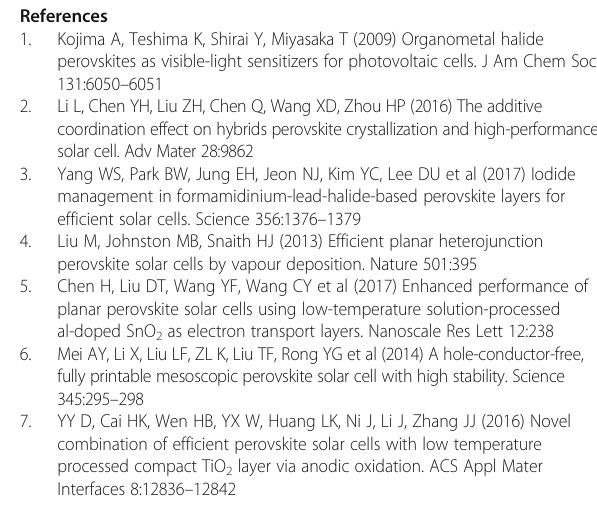
Figure S3. AFM height profiles of the different c-TiO 2 spin-coating on the FTO glass obtained from the 5 μ m scale, (a) the underlying FTO, (b) c-TBOT, (c) c-TTIP, and (d) c-TTDB. This data can also clearly reveal the roughness of the various substrates. Figure S4. Transmission spectra of different